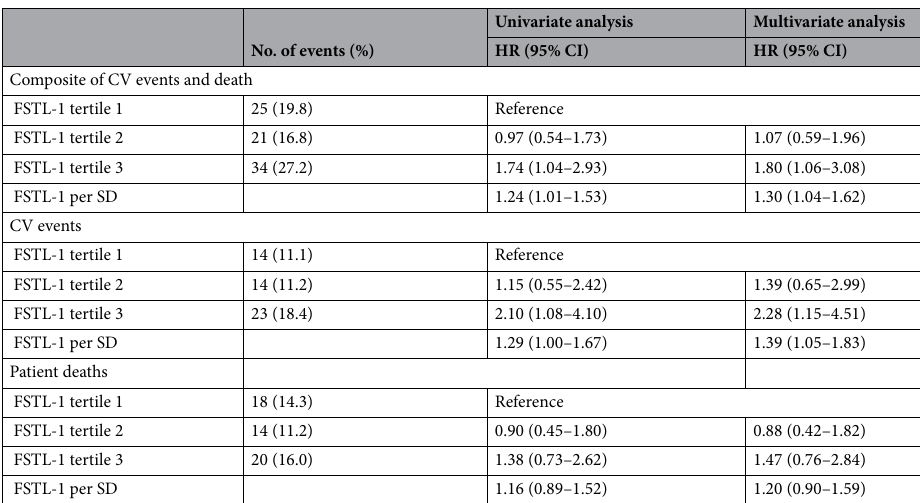
Table 4. Hazard ratios for a composite of CV events and death, CV events, and all-cause deaths. All analyses were adjusted for the following covariates: age; sex; BMI; Charlson comorbidity index; spKt/V; and levels of hemoglobin, hsCRP, LDL cholesterol and i-PTH. FSTL-1 follistatin-like protein-1, BMI body mass index, hsCRP high-sensitivity C-reactive protein, LDL-cholesterol low-density lipoprotein cholesterol, i-PTH intact parathyroid hormone, no. number, HR hazard ratio, CI confidence interval, SD standard